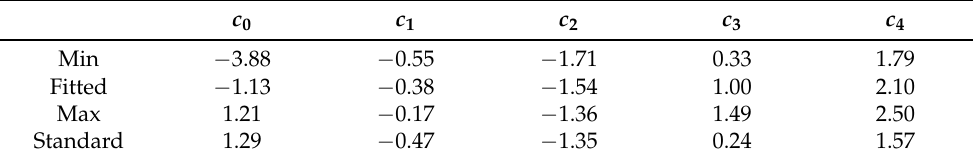
Table 2. Fitted model coefficients, outer bounds of the 95% confidence interval from a 10,000 repetition bootstrap analysis, and standardized (or beta) coefficients. c 0 is the intercept, c 1 is the drag-corrected Re c term, c 2 is the total kinetic energy (TKE) term, c 3 is the density ratio term, and c 4 is the diameter ratio term.